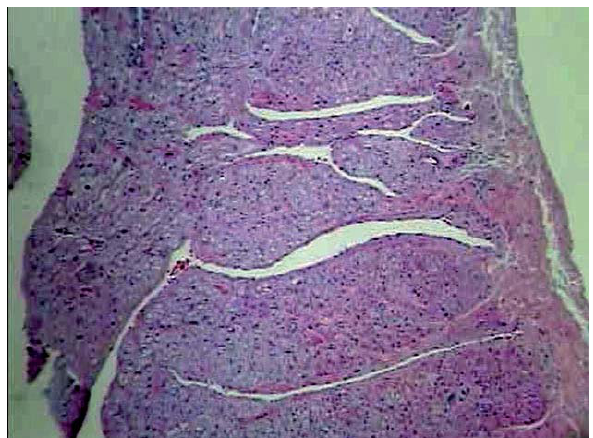
Fig. 5 – Tecido muscular cardíaco ventricular esquerdo com trabéculas de musculatura estriada disposta em fendas vasculares de permeio, característico de miocárdio não compactado. HE - 40